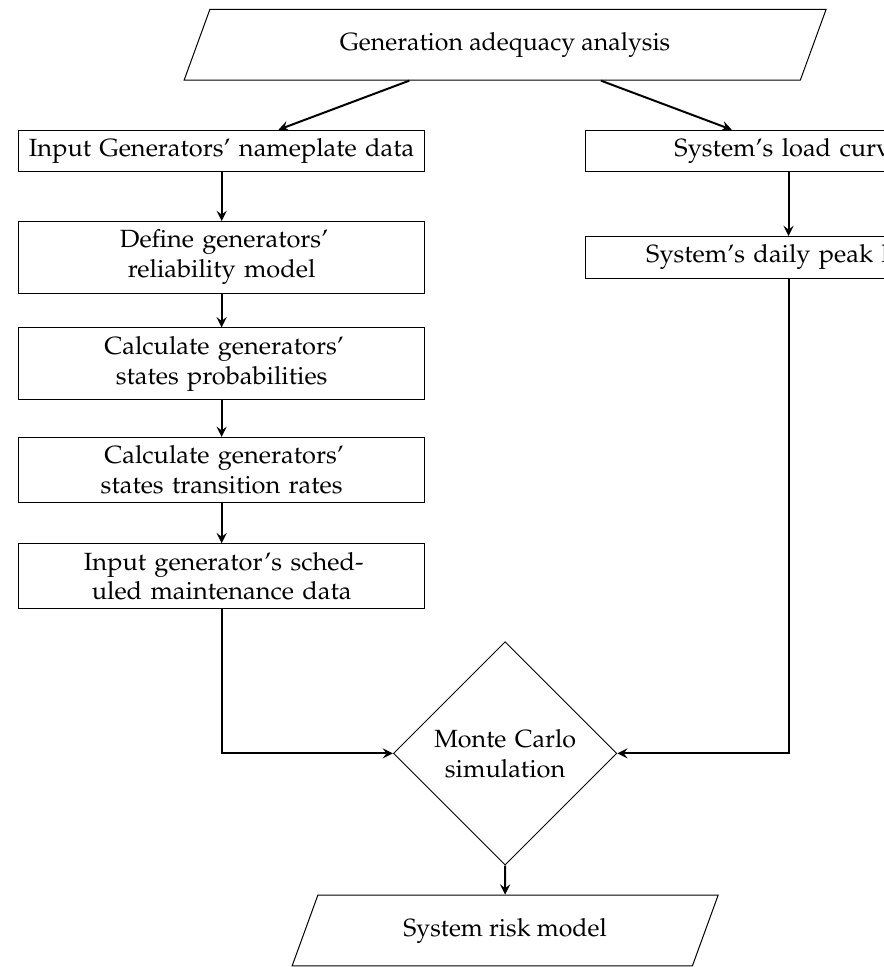
Figure 1. System modeling for generation adequacy